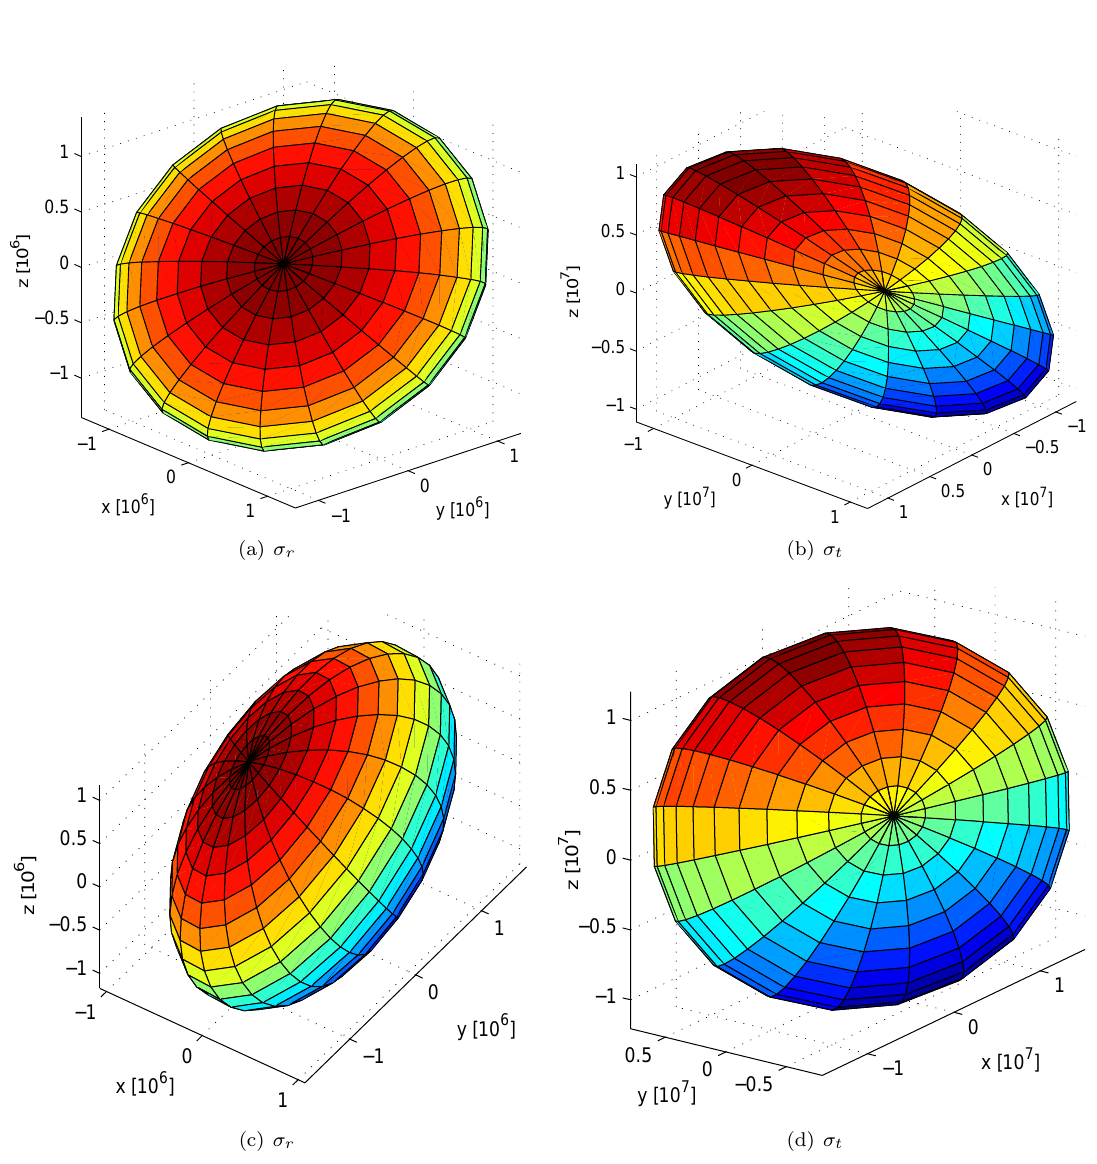
Figure 11: Stiffness ellipsoids: (a) and (b) at orientation [75 o , 45 o , 0] when the SPM has the minimum rota- tional stiffness; (c) and (d) at orientation [20 o , 45 o , 0] when the SPM has the minimum translational